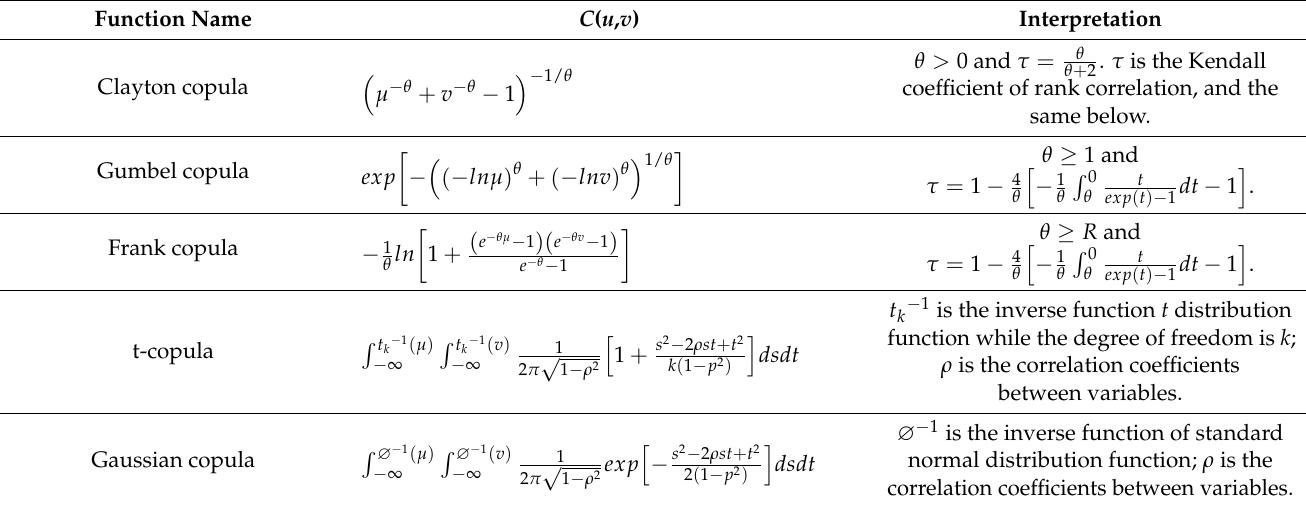
Table A1. Equations of the copula functions in this